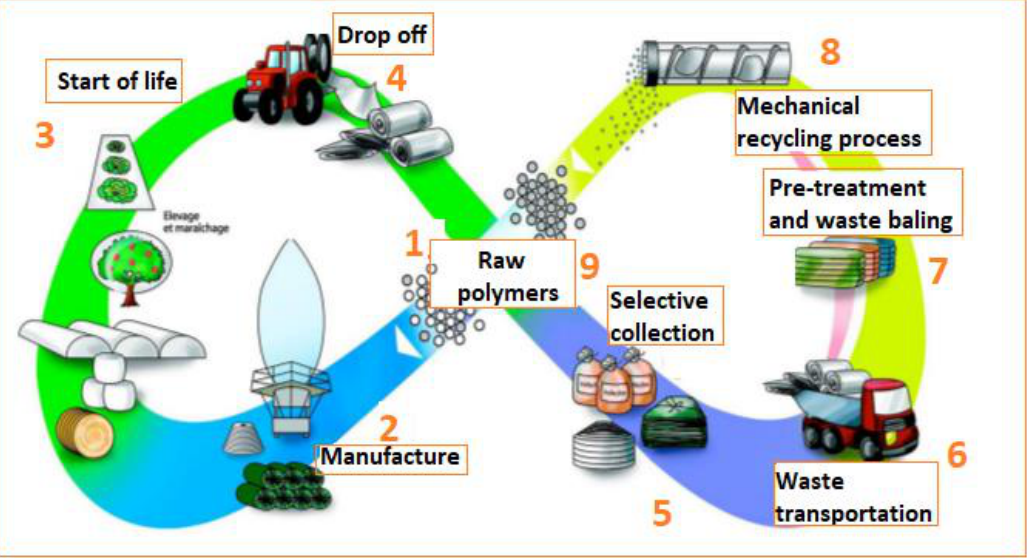
Figure 8. Schematic of the agricultural plastics film’s life cycle in the context of a circular economy. Adapted from [60].